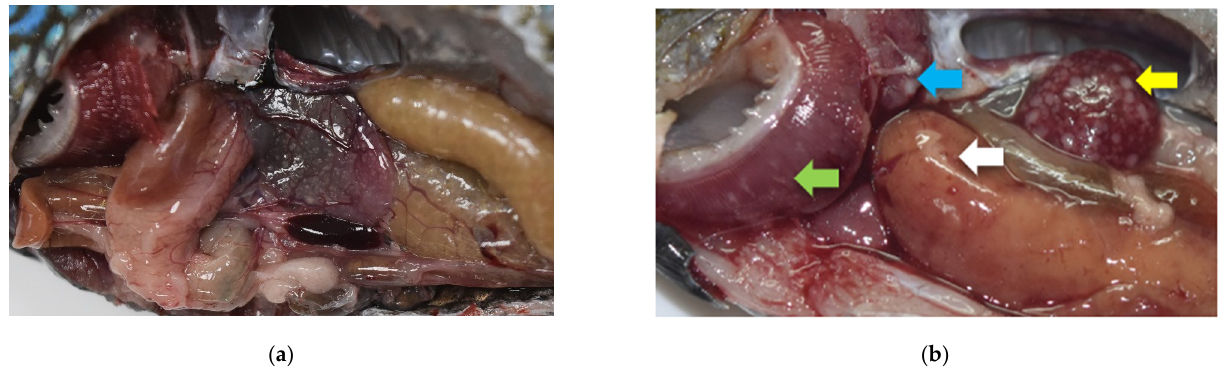
Figure 1. Gross pathological lesions of francisellosis observed in the challenged fish ( b ) when compared with the control fish ( a ) at day 11 post infection. Splenomegaly and renomegaly seen along with multifocal white modules in spleen (yellow arrow), head kidney (blue arrow), liver (white arrow), and gills (green arrow). Table 1. Necropsy results of Fo infected fish that died in the experimental period. Degree of Severity